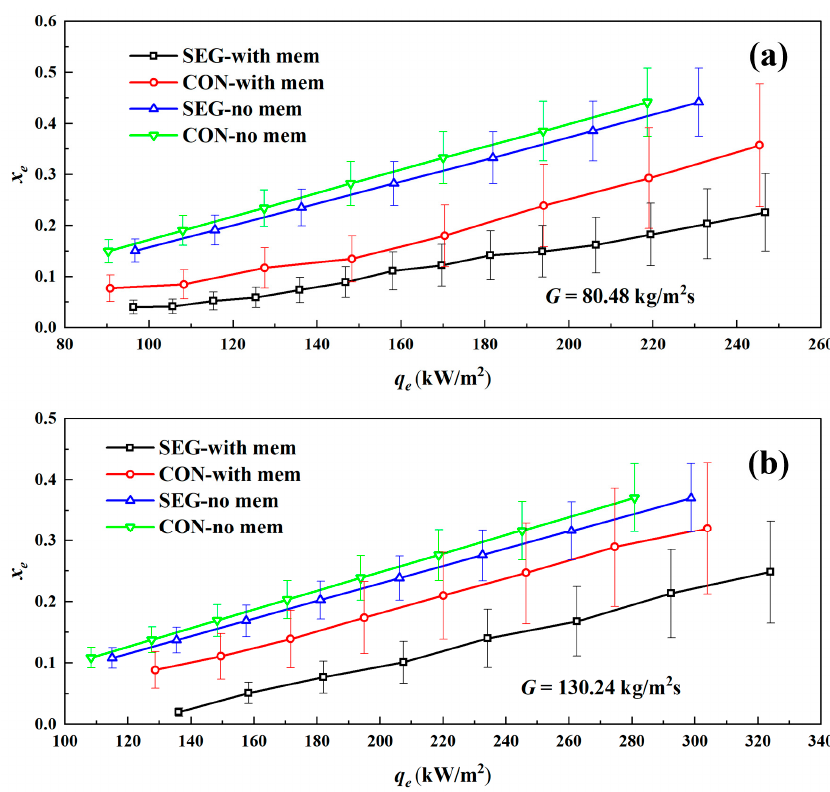
Figure 11. Pressure drops in the continuous and segmented heat sinks with and without the venting membrane: ( a ) G = 80.48 kg m − 2 s − 1 ; ( b ) G = 130.24 kg m − 2 s − 1 .